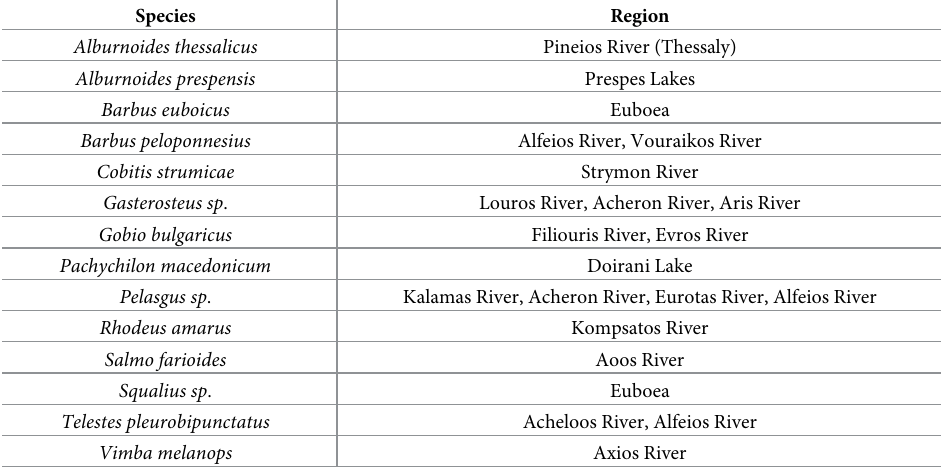
Table 3. Populations of species with region specific